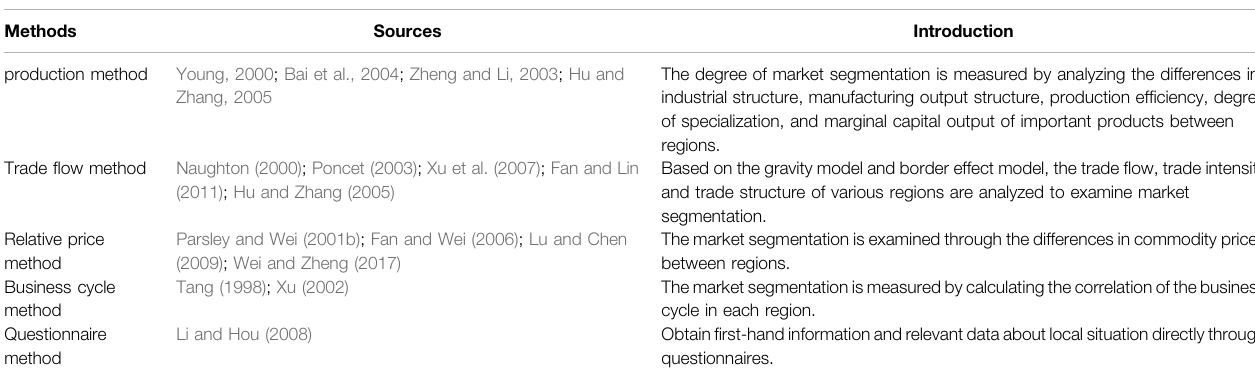
TABLE 5 | Measurement of market segmentation index.